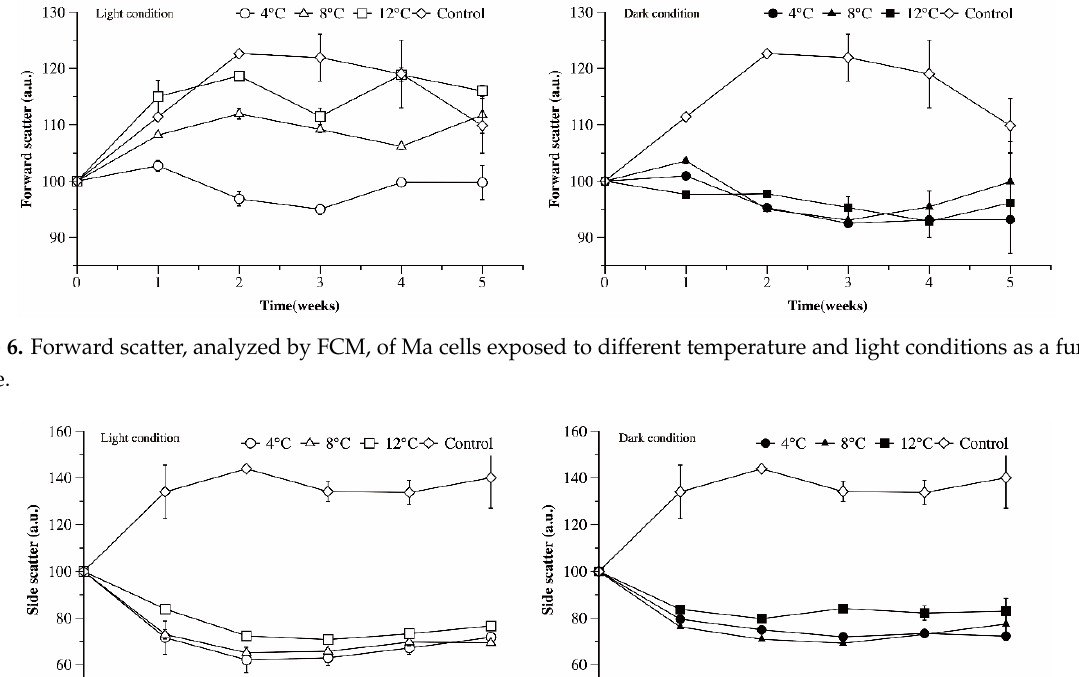
Figure 6. Forward scatter, analyzed by FCM, of Ma cells exposed to different temperature and light conditions as a func- tion of time.